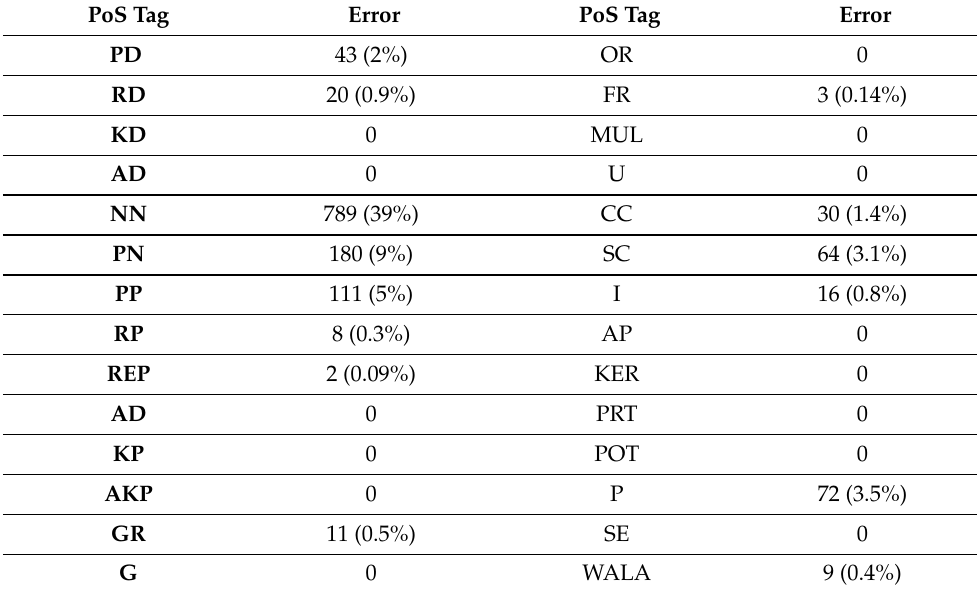
Table 10. Error Analysis of the without-PoS-DLA approach with respect to PoS